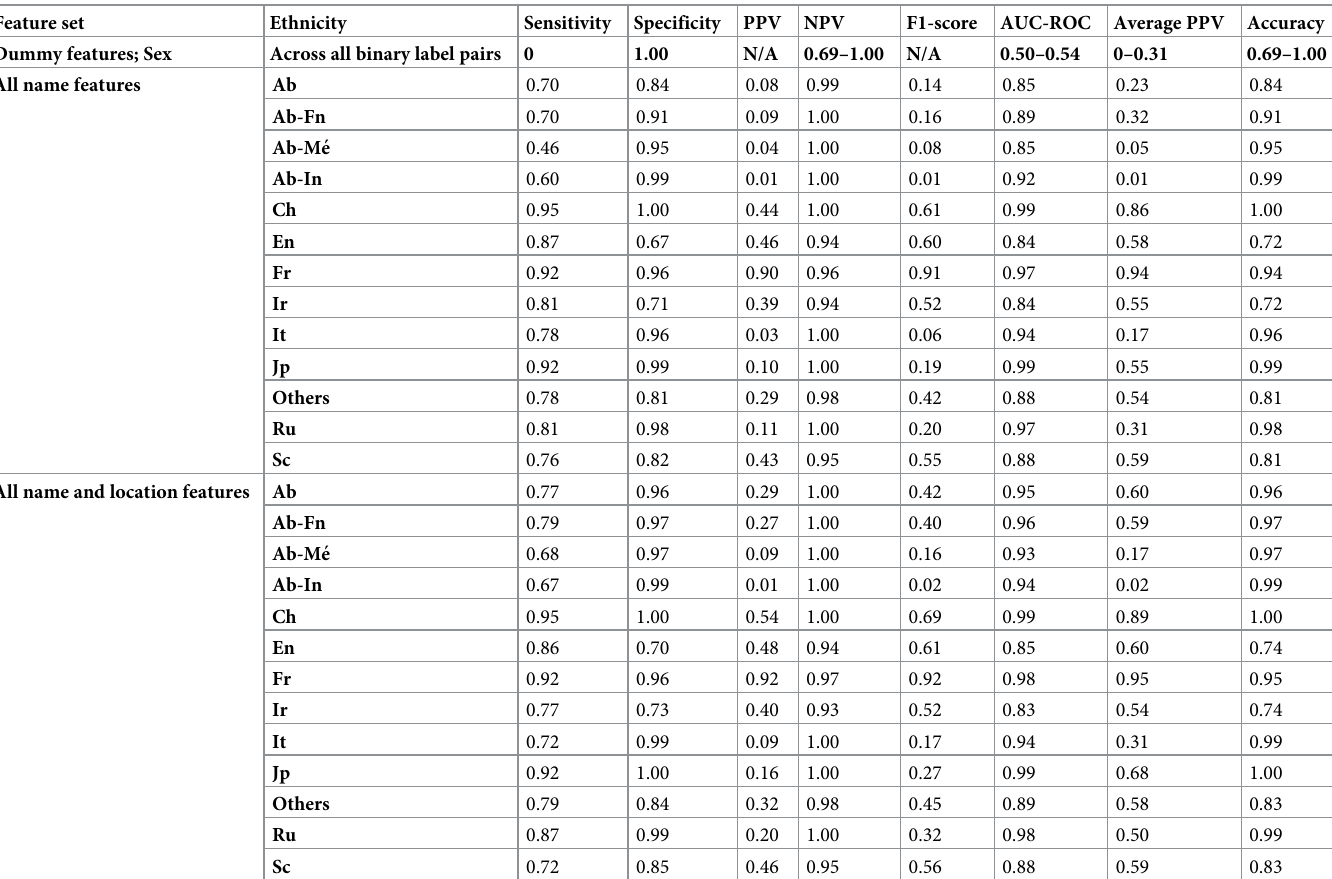
Table 8. Binary classification predictive performance in test set based on na ï ve Bayes classifiers trained in training set. Feature